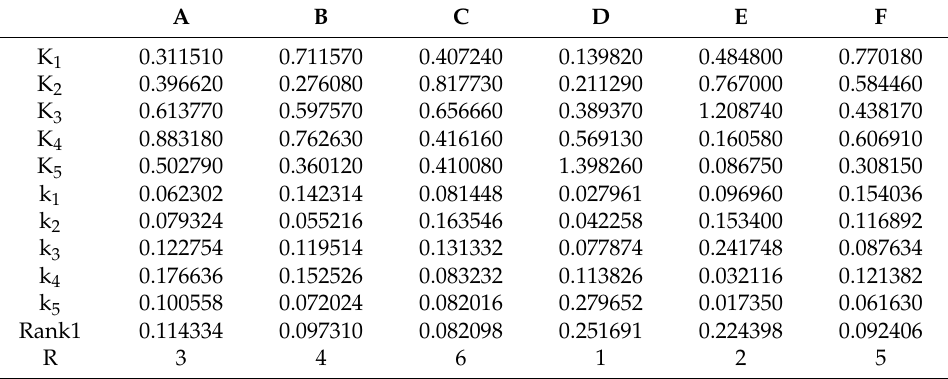
Table 4. Extreme difference analysis for the void volume fraction on the neck of the clinched